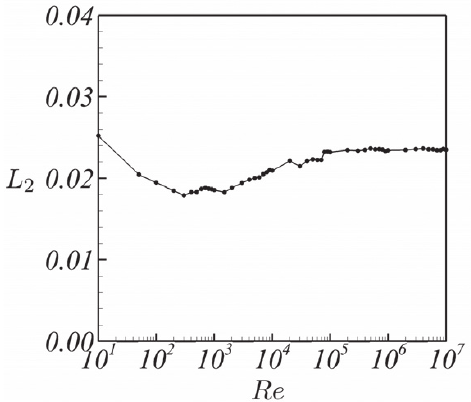
Figure 17 - L 2 norm of the velocity at the immersed boundary for different Reynolds